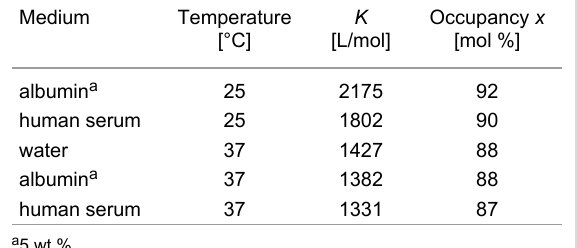
Table 4: Binding data for sevoflurane in 3b 1 for various media and